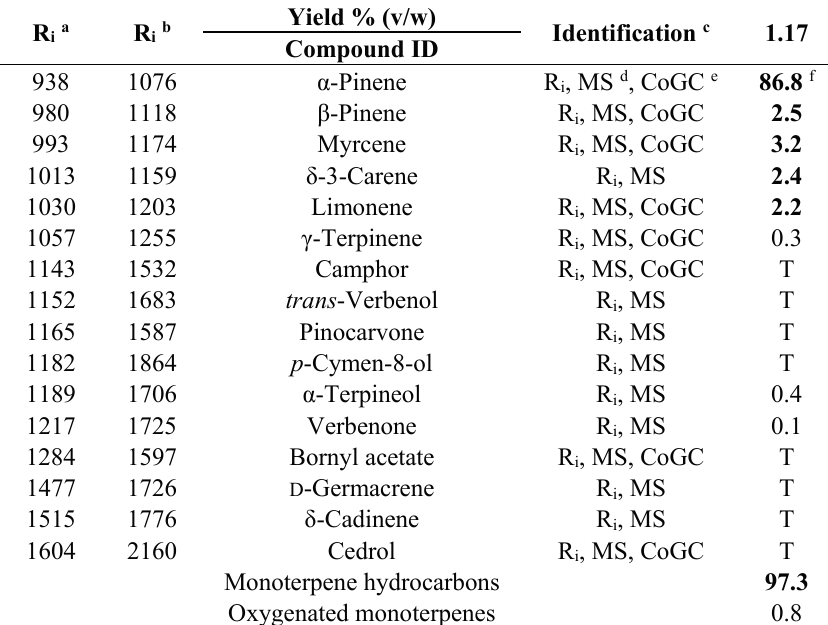
Table 1. Chemical composition (%) and yield of essential oil obtained by hydrodistillation from berries of Juniperus excelsa M.